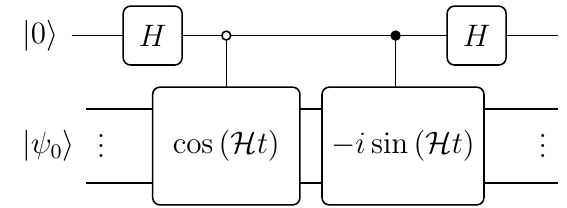
FIG. 17. One quantum circuit that can be used to construct the time evolution operator cos ( H t ) − i sin ( H t ) = e − i H t and apply it to | ψ 0 (cid:6) , for use in Hamiltonian simulation as described in Algorithm 4. Note that the correct evolution of the input state (cid:6) is achieved only upon postselection of the auxiliary qubit | ψ 0 in the | 0 (cid:6) state. One can achieve this with either repetition or fixed-point amplitude amplification, similar to projecting into the desired block of the QSVT sequence operator as discussed at the end of Sec. II